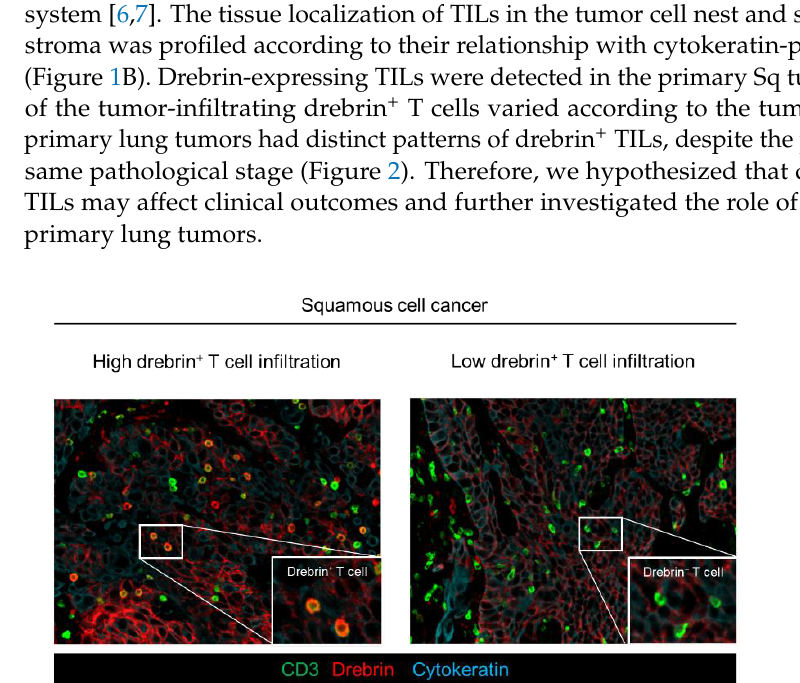
Figure 2. Distinct patterns of drebrin-expressing TILs among lung cancer patients. Representative images of drebrin + TILs from two patients diagnosed at the same pathological stage. Pan-cytokeratin (blue) of tumor cells, CD3 (green), and drebrin (red) were simultaneously stained. Drebrin + or drebrin − TILs are shown at a high magnification. TILs, tumor-infiltrating